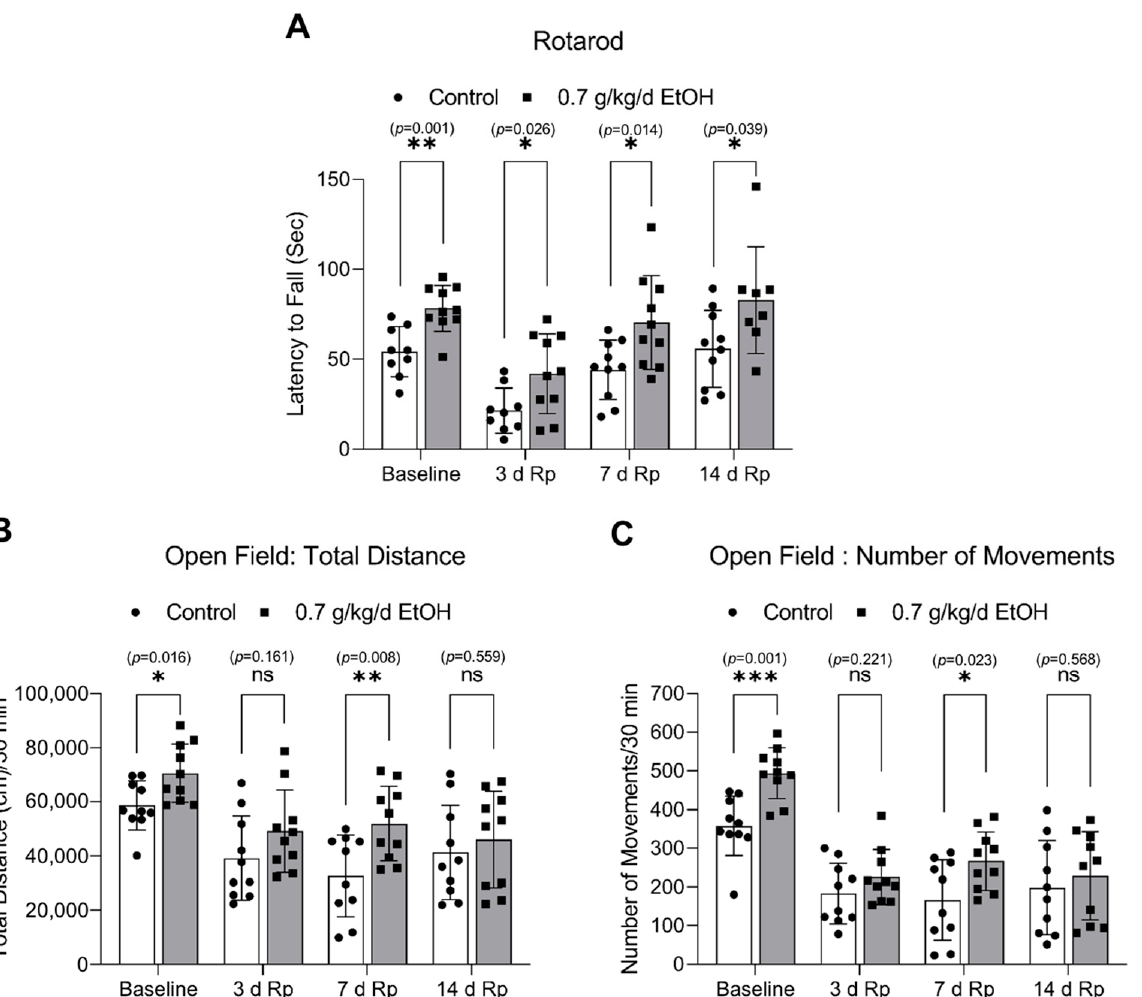
Figure 8. Effect of LAC on the locomotor activity under physiological conditions and following transient focal cerebral ischemia. ( A ) The latency to fall from the accelerating rotarod. ( B ) The total distance traveled during the 30-min trial in the open field test. ( C ) The number of movements during the 30-min trial in the open field test. Values are means ± SD ( n = 10); * p < 0.05; ** p < 0.01; *** p < 0.005 vs. Control. Analyzed using an unpaired t -test.